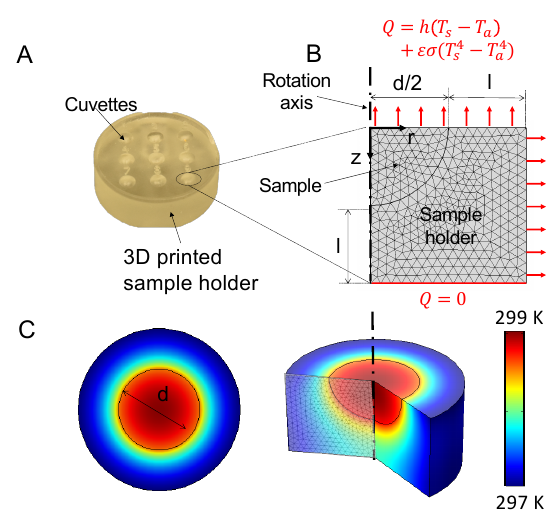
Figure 2. ( A ): Picture of the custom-made polystyrene sample holder designed to investigate NP samples in the liquid state. 9 identical semi-spherical cuvettes allow for the simultaneous investigation of multiple samples. ( B ): 2D axi-symmetrical model of one single cuvette with the surrounding sample holder. The cuvette diameter d as well as the sample holder thickness l can be varied. The sample is considered to be a homogeneous heat source. Convection and radiation losses take place at the sample and sample holder surfaces, whereas the bottom of the sample holder is insulated. A tetrahedral finite element mesh is used, with a mesh size chosen to ensure numerical stability. ( C ): Simulation results of the sample holder surface and bulk temperature computed using the numerical model described in Section